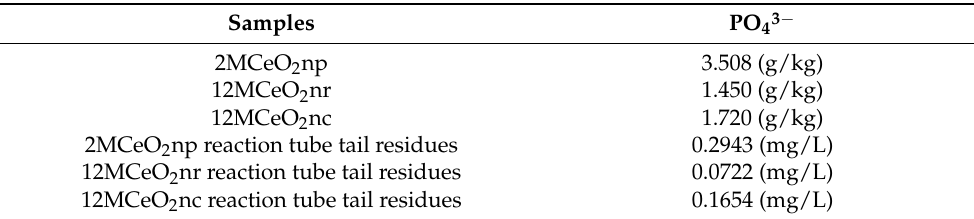
Table 5. Content of PO 43 − on various CeO 2 materials and at the end of the reaction tube after catalytic decomposition of